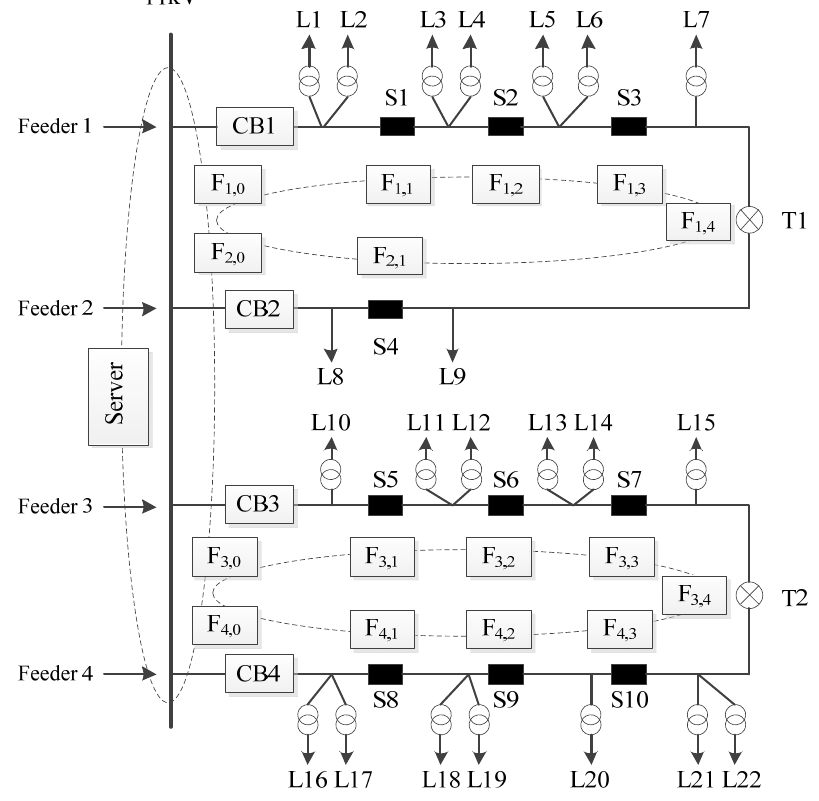
Figure 4. Distribution system for RBTS bus 2 including FRTUs.